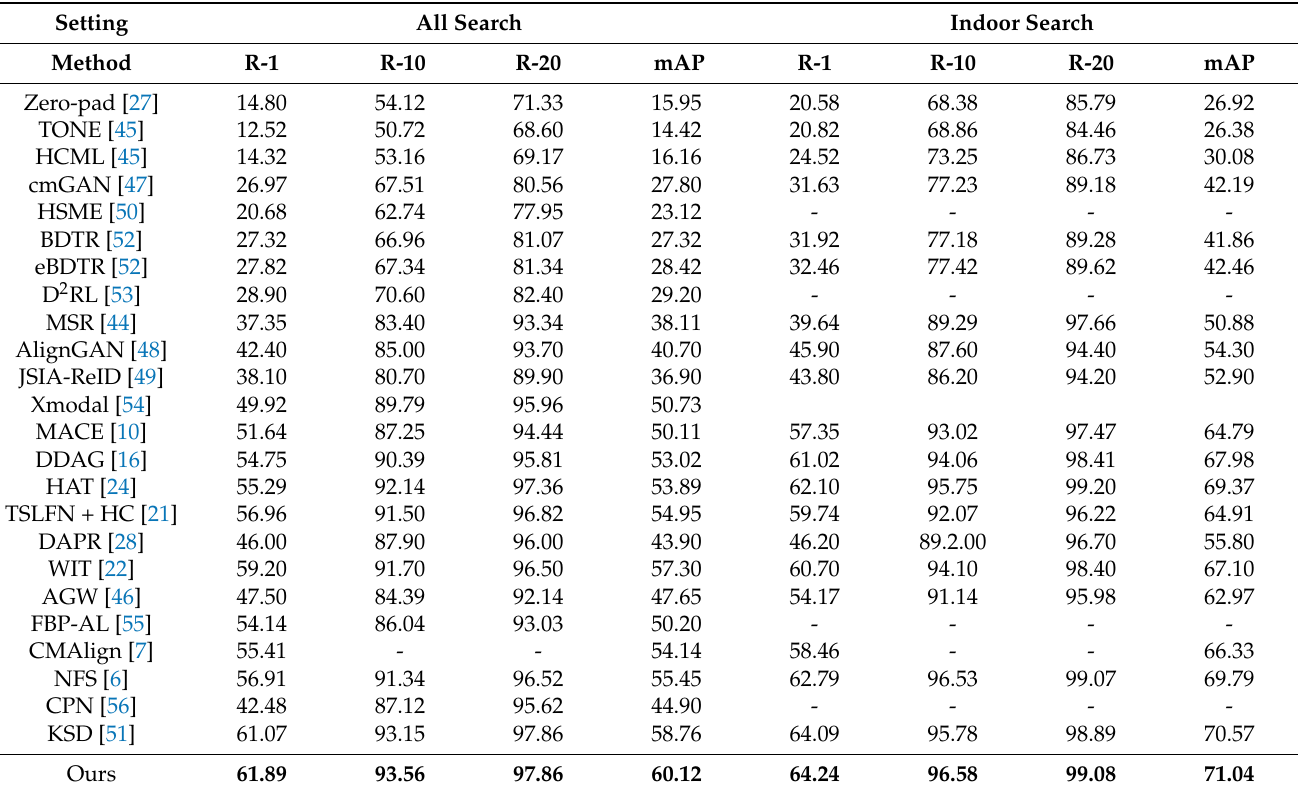
Table 1. Comparisons with the state-of-the-art methods on SYSU-MM01 with two different settings. R-i indicates Rank-i. The bold indicates the best